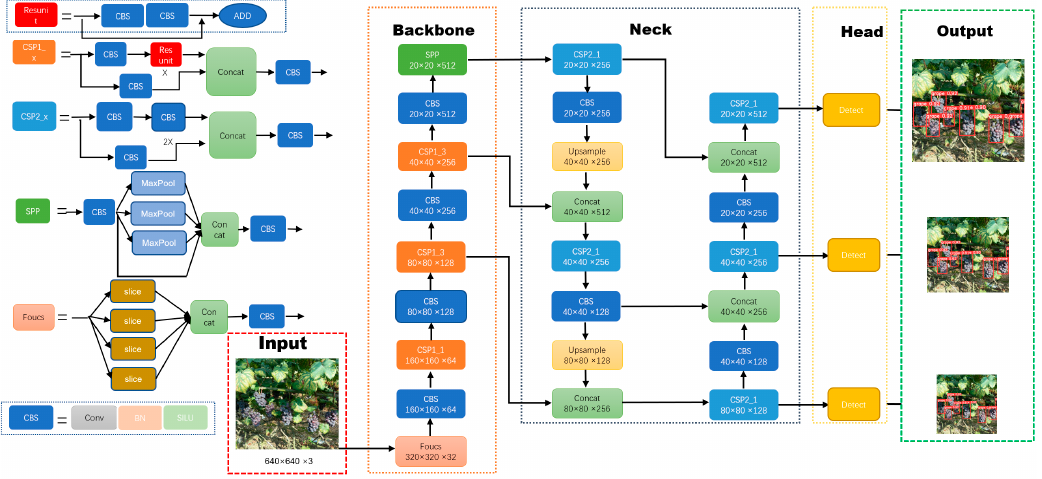
Figure 5. Structure of the grape cluster detection model based on YOLOv5s.